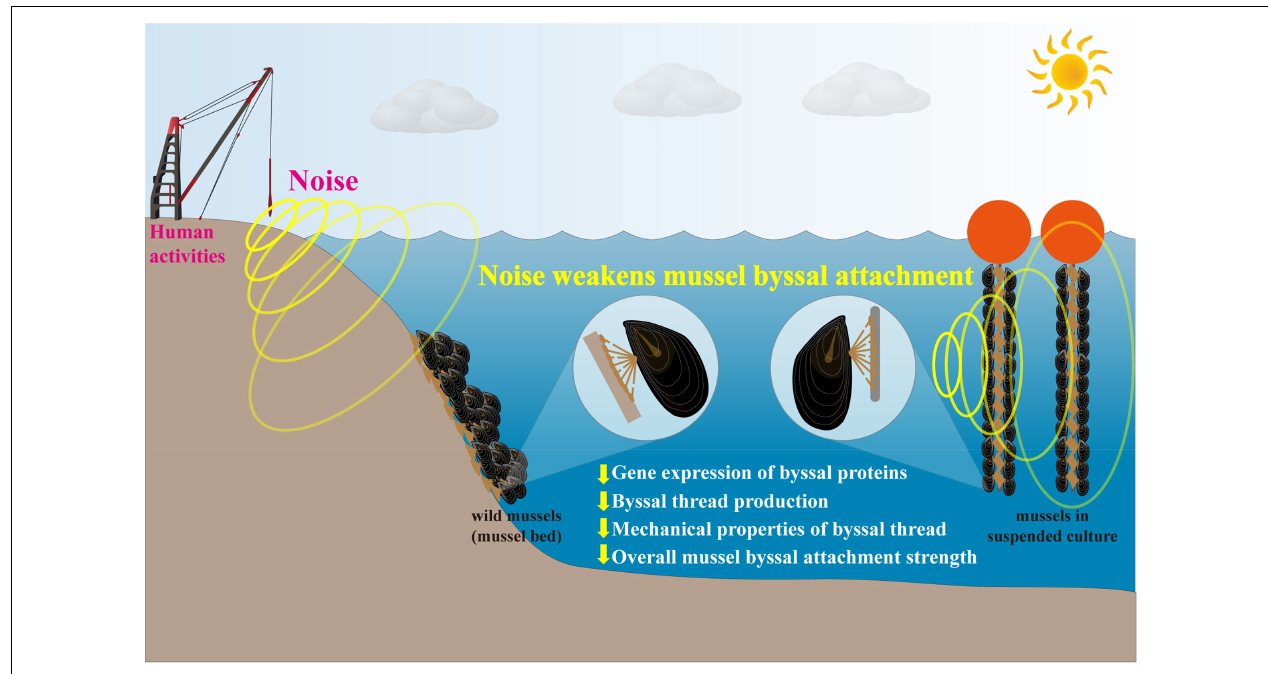
FIGURE 7 | Schematic diagram showing the main findings and implications of this study. Exposure to playbacks of the pile-driving noise significantly weakened gene expression of byssal proteins, secretion of byssal threads and their mechanical performances, which eventually led to a 16.95–44.50% decrease in the overall mussel byssal attachment strength. In conclusion, anthropogenic noise (e.g., the pile-driving noise) has negative impacts on both mussel individuals and population through hampering byssal attachment, in turn posing a great threat to mussel-bed community and mussel aquaculture